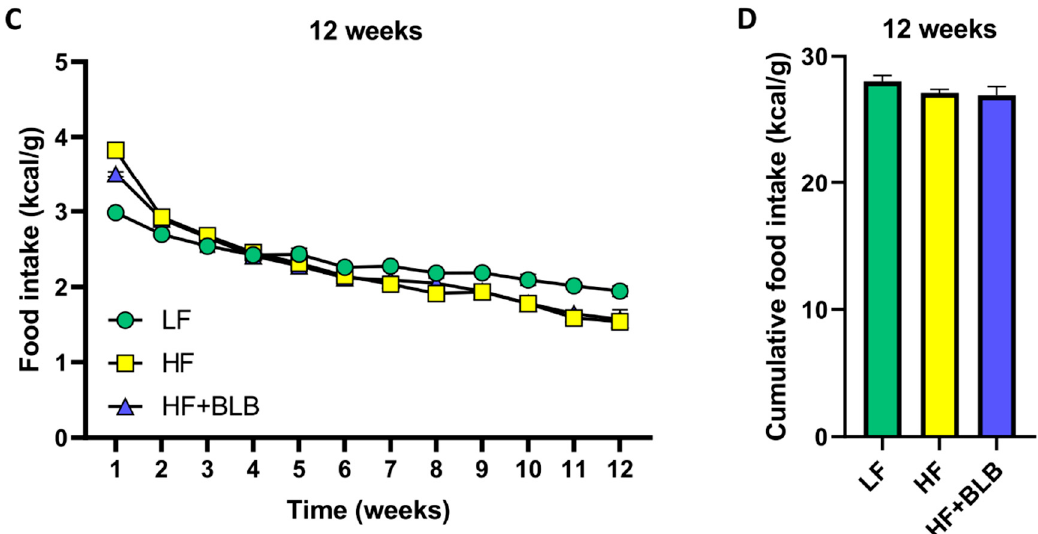
Figure 2. The food intake. The mice received a low-fat diet (LF, 10% of energy from fat, circle), a high-fat diet (HF, 46% of energy from fat, square) or a bilberry-supplemented high-fat diet (HF+BLB, 20% air-dried bilberry powder, triangle) for six ( A , B ) or twelve ( C , D ) weeks. The weekly food intake was analyzed with repeated measures, such as a two-way (mixed model) ANOVA and a Bonferroni multiple comparisons test ( A , C ). The cumulative food intake was analyzed with a one-way ANOVA and a Bonferroni multiple comparisons test ( B , D ). The statistically significant difference between the HF and LF groups in the first week is marked as a = p < 0.05. The results are expressed as energy unit per body weight (kcal/g); values represent mean ± SEM, and n = 6 for the statistical analysis since the mice were housed as two in a cage; n = 12 mice in each group.